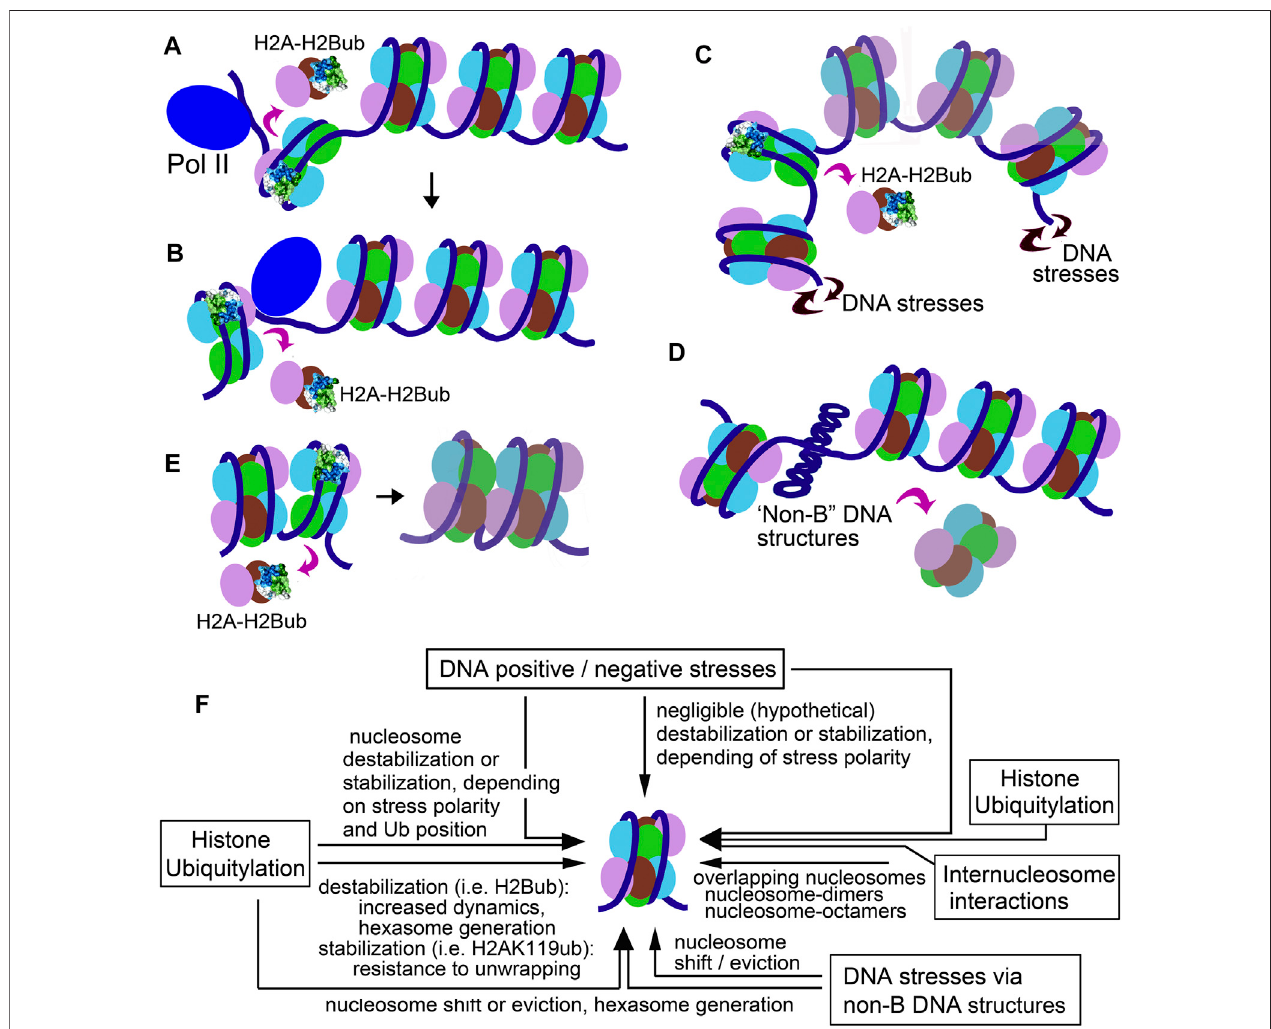
FIGURE 2 | Sketches illustrating the nucleosomal effects of H2Bub. (A,B) RNA Pol II traversing the H2B-ubiquitylated nucleosome. (A) Eviction of the promoter- proximal H2A-H2B dimer promotes the polymerase complex to enter the nucleosome; (B) Eviction of the promoter-distal H2A-H2B dimer promotes RNA Pol II to successfully elongate through the nucleosome. (C) Hexasome generation by DNA stresses. (D) Nucleosome rearrangement by transition of a DNA segment to a cruciform structure. (E) Formation of “ overlapping ” nucleosomes. (F) Schematic fi gure, depicting how different mechanisms (histone ubiquitylation, DNA stress, and internucleosome interaction) could cooperate to regulate chromatin dynamics and